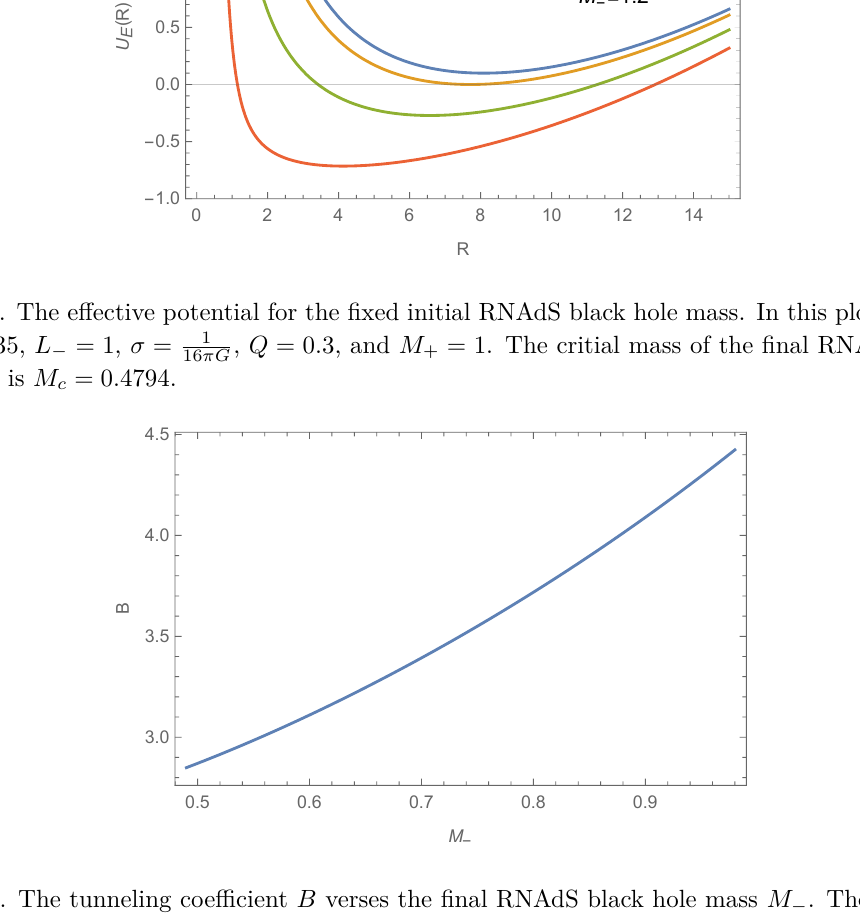
Figure 8 . The tunneling coefficient B verses the final RNAdS black hole mass M − . The range of M − is from the minimum critical mass to a relative large value. In this plot, G = 1 , L + = 1 . 335 , L − = 1 , σ = 1 , Q = 0 . 3 , and M + = 1 . The critical mass of the final RNAdS black hole mass is 16 πG M c = 0 . 4794